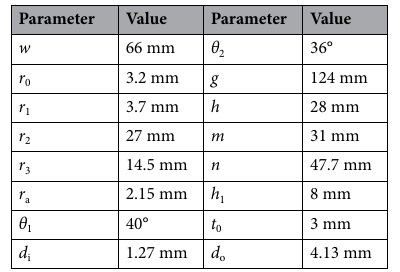
Table 1. Geometrical parameters of the proposed antenna.